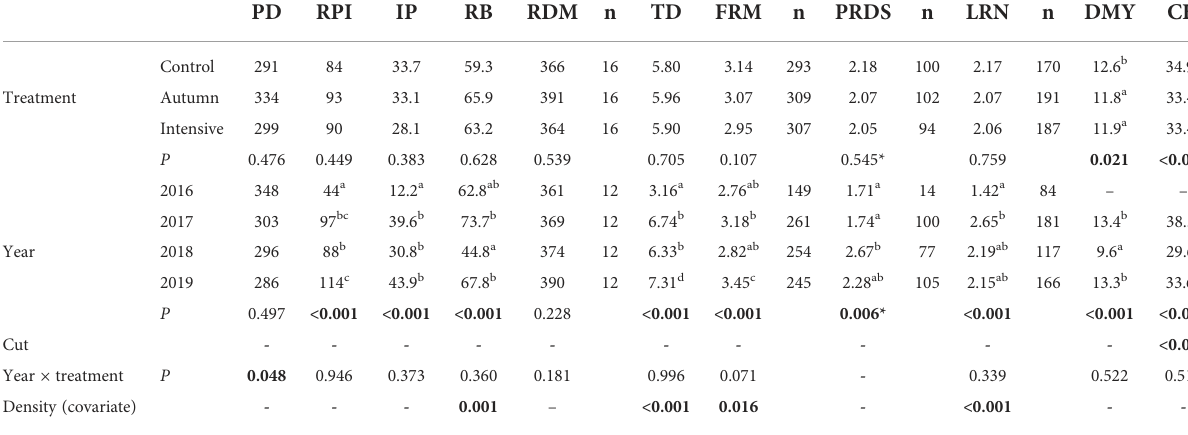
TABLE 3 Effect of treatment and year for Site 1 (C ̌ erveny ́ U ́ jezd) on lucerne plant density (PD, plant m -2 ), root potential index (RPI), ratio of infected plants (IP, as %), ratio of branch-rooted plants (RB, as %), total root dry matter (RDM, g m -2 ), tap root diameter (TD, mm), fi ne root mass score (FRM), plant root disease score of infected plants (PRDS), lateral root number at branch-rooted plants (LRN, pcs plant -1 ), dry matter yield (DMY, t ha -1 ) and compressed stand height (CH, cm).